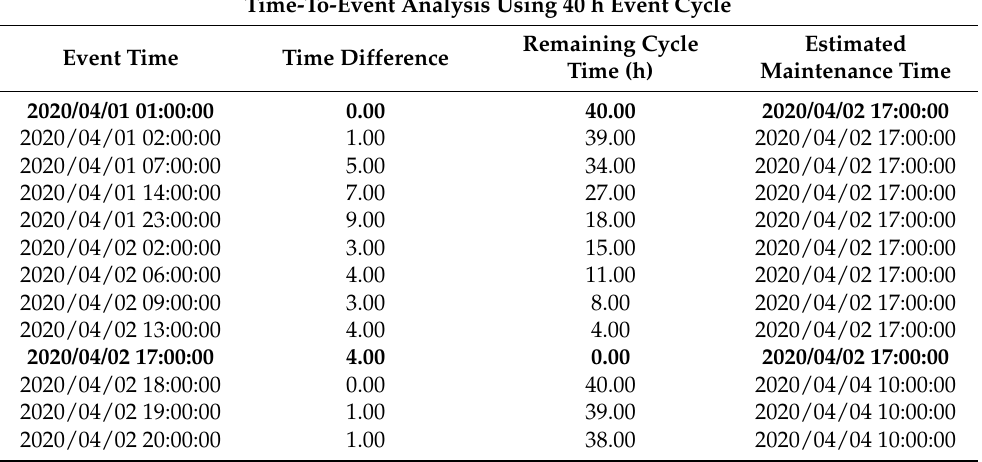
Table 4. Cycle time method for maintenance time